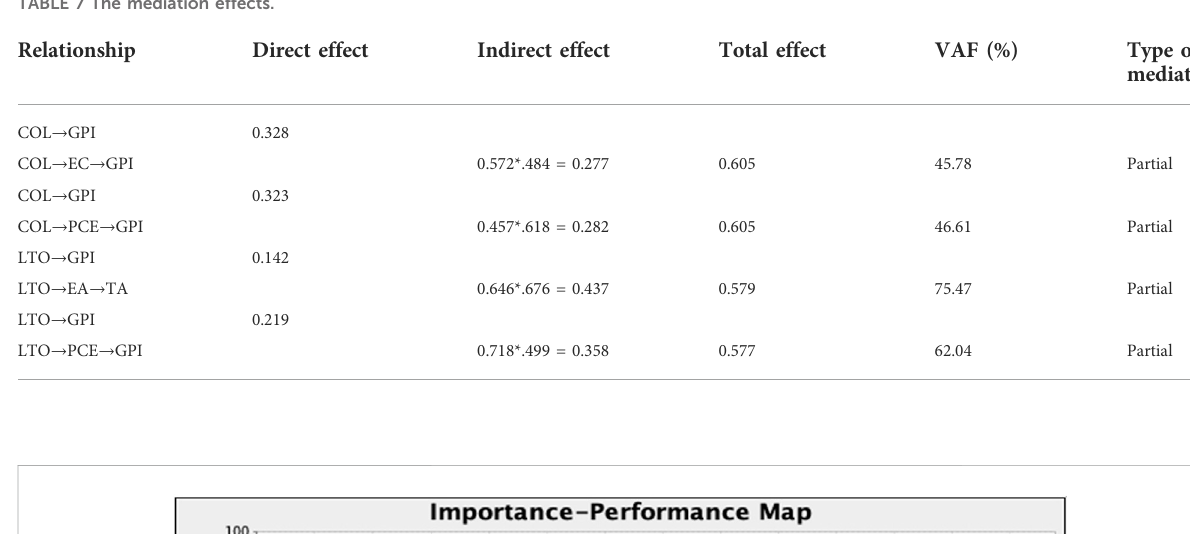
TABLE 7 The mediation effects.